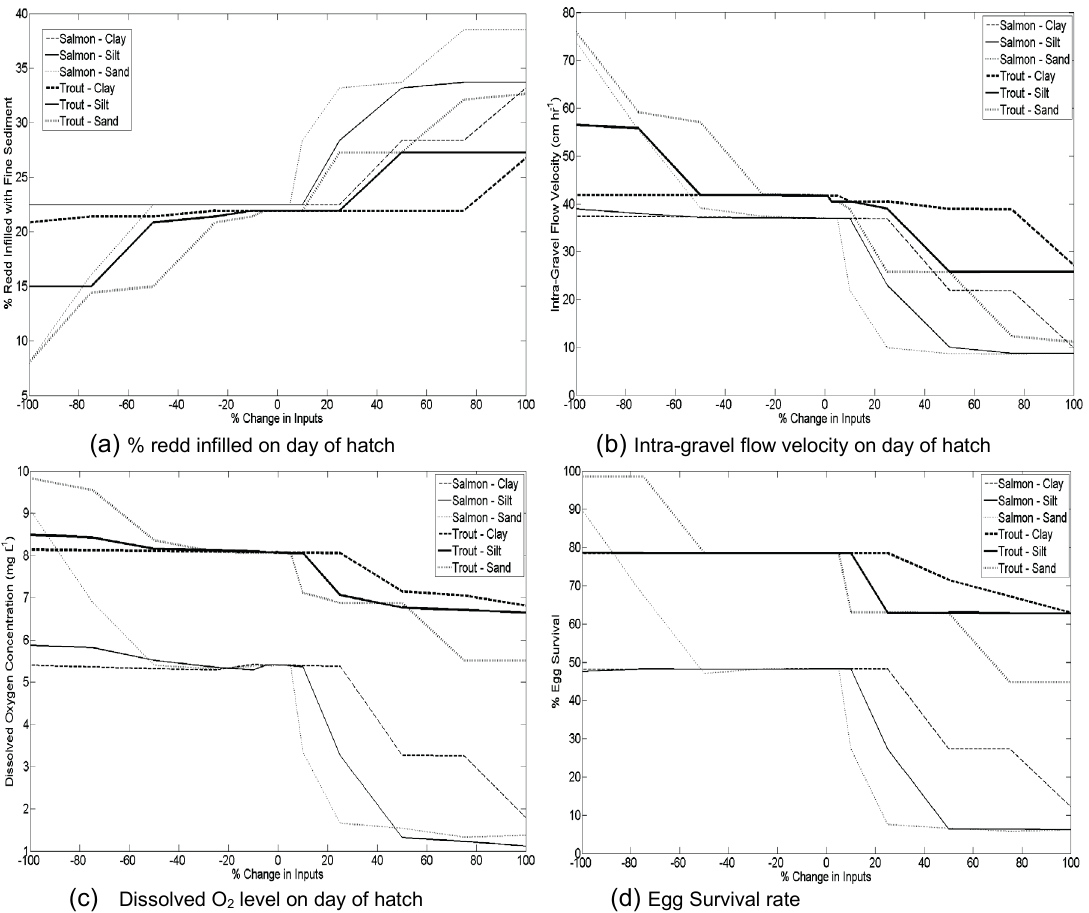
Fig. 6 Impact of changing sediment loads on: (a) infilling; (b) intra-gravel flow velocities; (c) dissolved oxygen concentrations; and (d) egg survival rate, on the day of hatch for Atlantic salmon and Brown